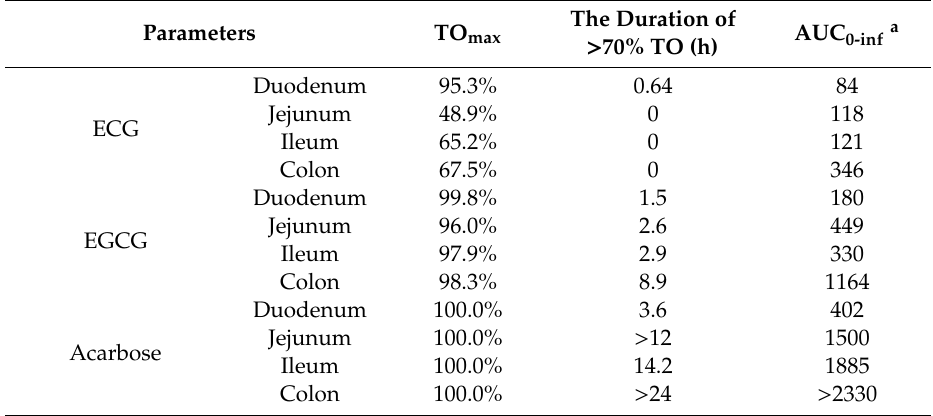
Table 3. Summary of key parameters of AGH engagement by ECG, EGCG (a single oral dose of 53 mg · kg − 1 to rat) and acarbose (a single oral dose of 50 mg to